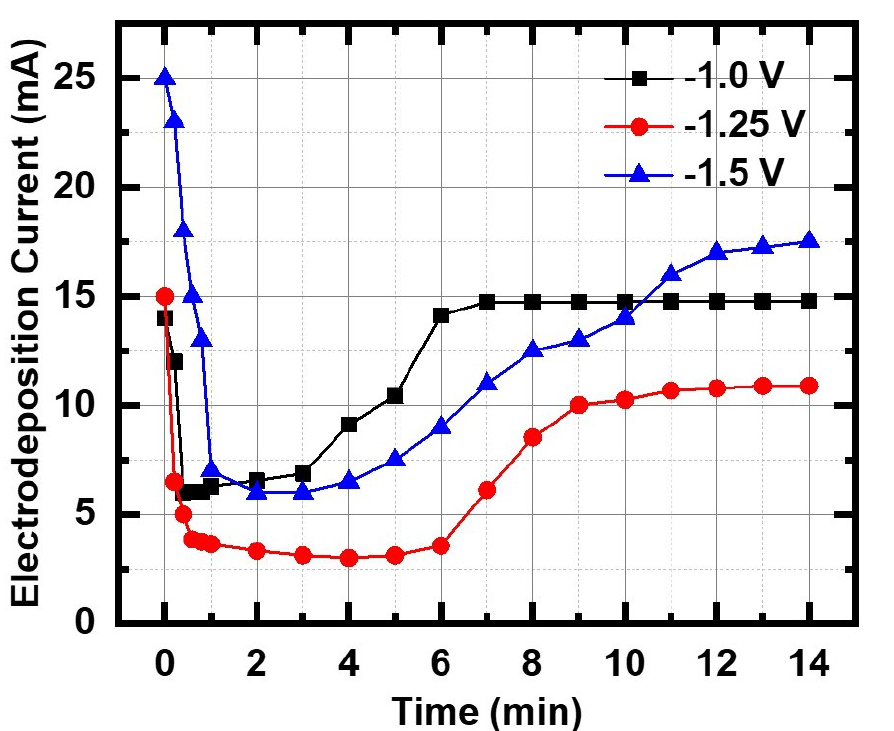
Figure 2. Current transient of room temperature InSb nanowire growth in Au-coated polycarbonate membrane at three different deposition potentials: